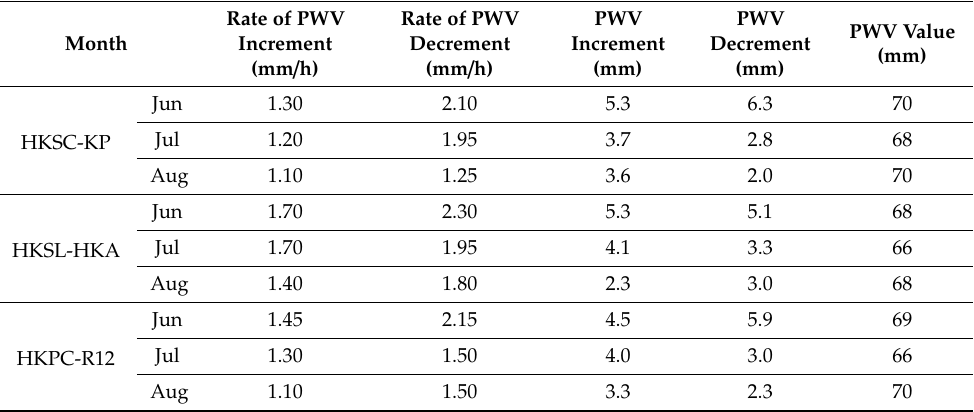
Table 8. Thresholds of five predictors determined for each summer month using sample data in the month over the period 2010–2017 from each of the three co-located